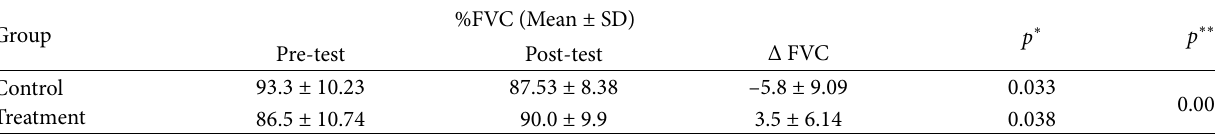
Table 3: Mean score of FVC before and after treatment.